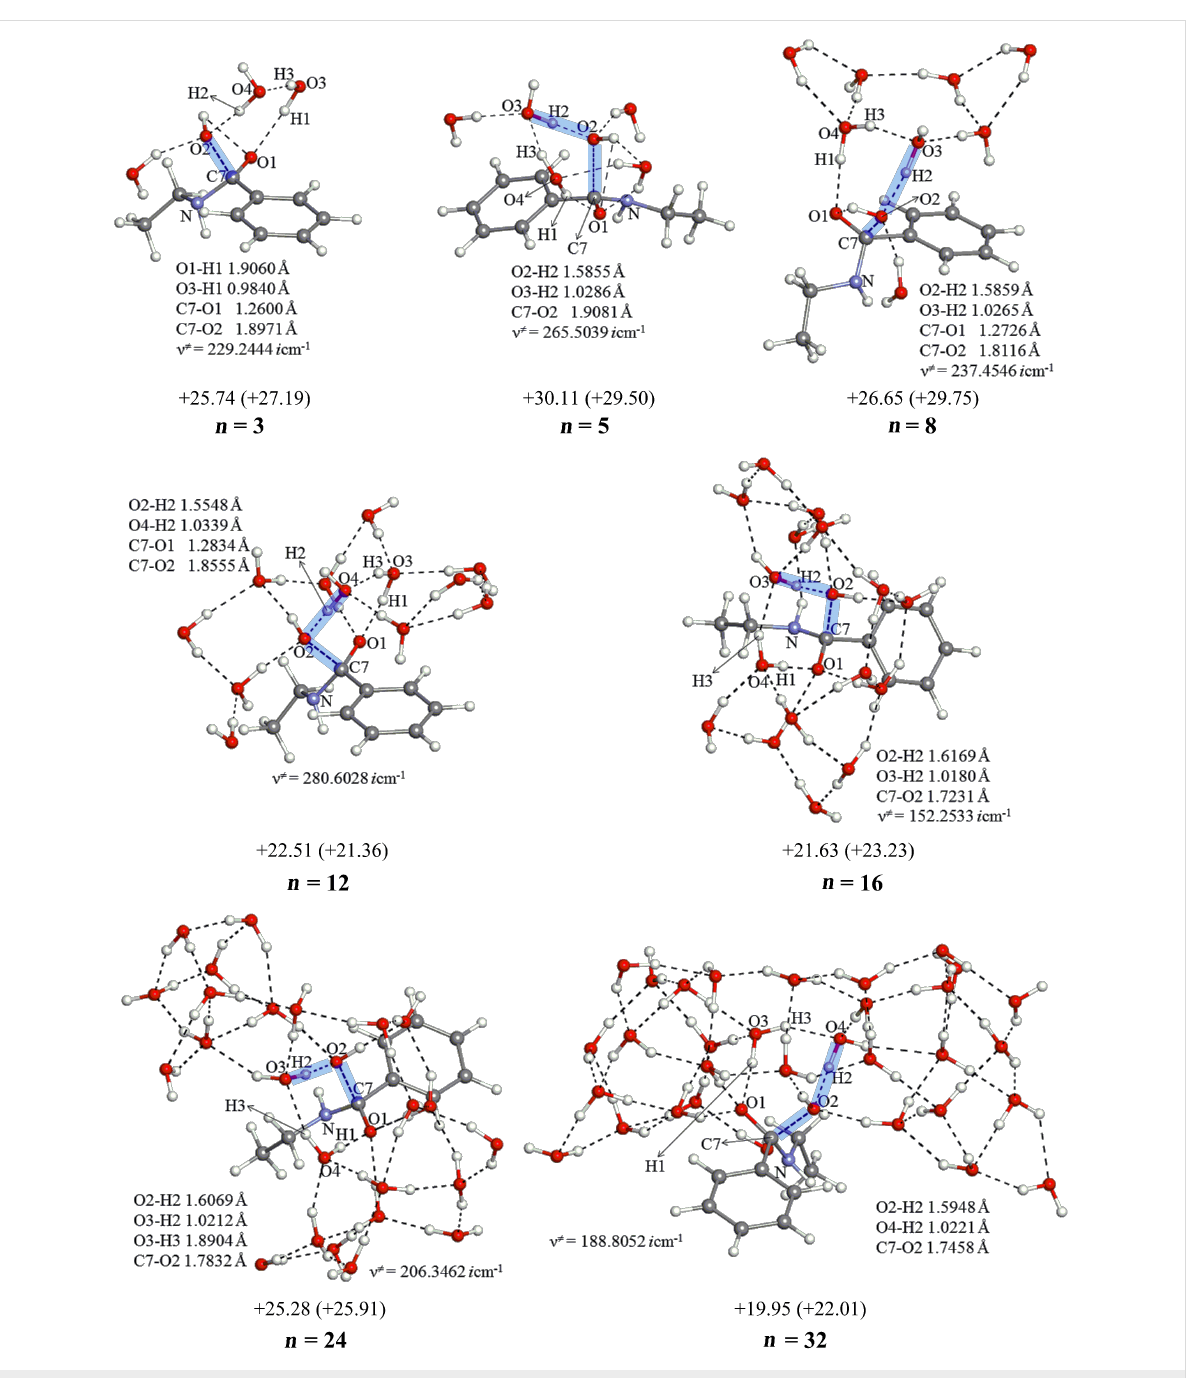
Figure 3: Geometries and activation energies of TS1(am) in the reaction between N -ethylbenzamide and OH - (H 2 O) n . XYZ coordinates in VII.b (Supporting Information File 1).